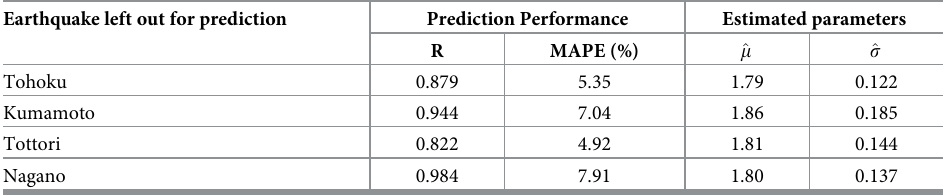
Table 2. Robustness test of fragility curve fitting results. The evacuation rates for the “left out earthquake” was pre- dicted by the model fitted by the other three earthquakes.